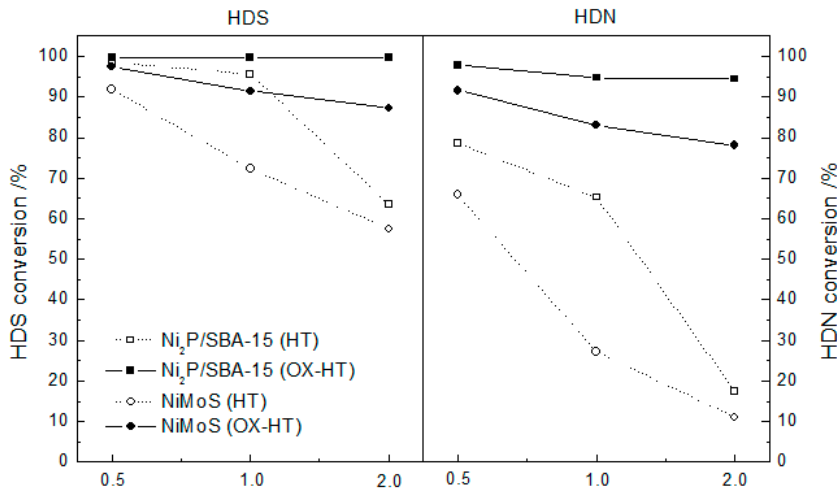
Figure 4. HDS and HDN conversions over Ni 2 P/SBA-15 and Ni-Mo-S at 3.0 MPa and 623